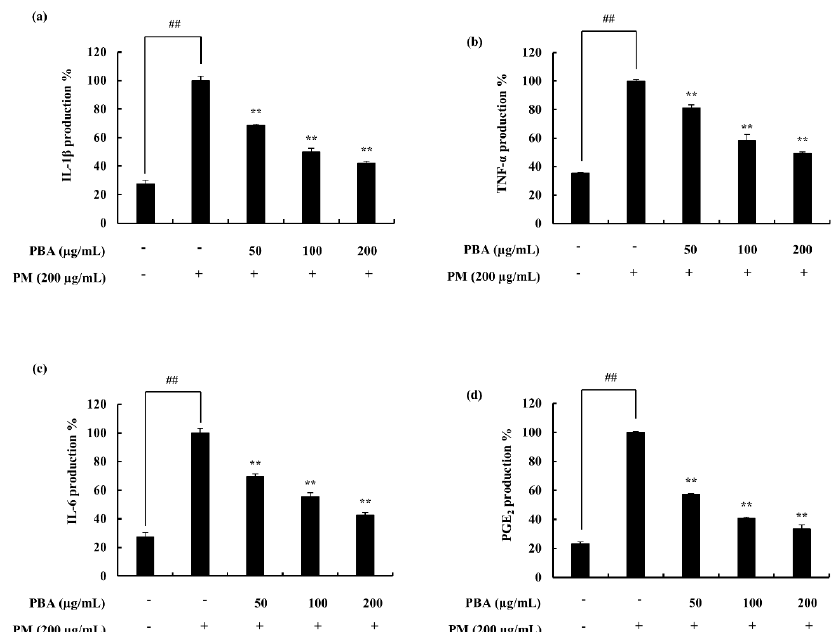
Figure 3. Effect of PBA on the keratinocytes and its production of inflammatory mediators (PGE2) including cytokines (IL-1β, IL-6, and TNF-α). Culture supernatants of RAW 264.7 cells after successful treatment of PM were used to quantify the inflammatory cytokines and PGE2. Triplicated experiments were used to evaluate the data and the mean value is expressed with ± SD. * p < 0.05, ** p < 0.01. (# denotes significance compared to control while * represents significance compared to PM treated